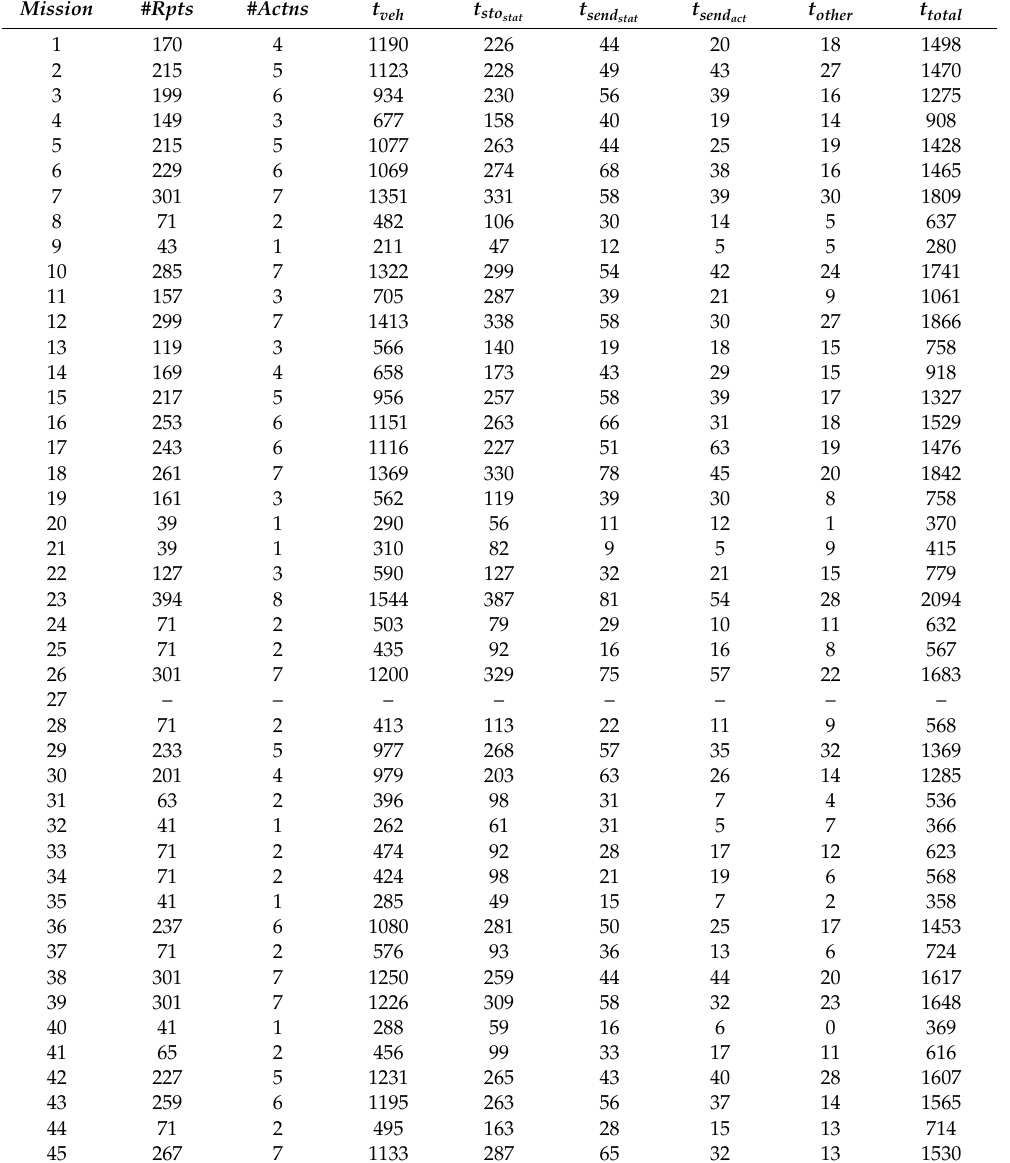
Table 5. Values for processing the task status reports, and if required send the next action to the corresponding vehicle. Time is given in